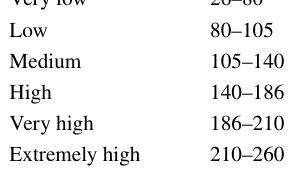
rating classes for SINTACS method (Civita and De Maio 1997)